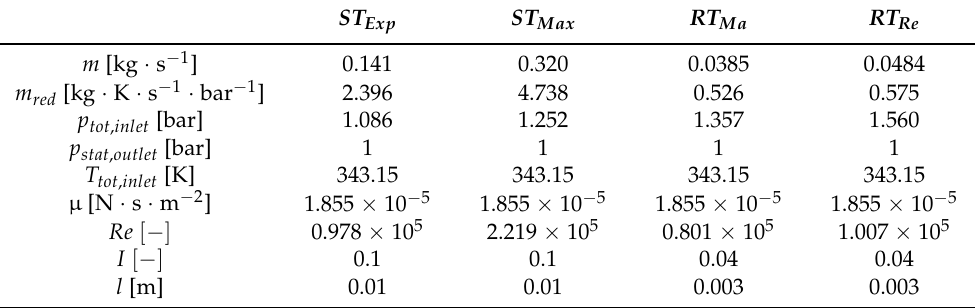
Table 3. Boundary conditions: VGT30.